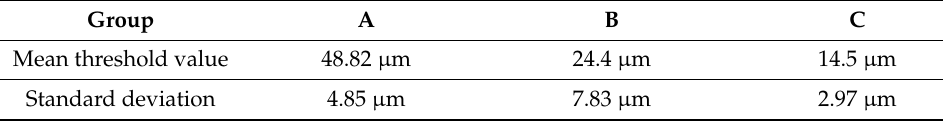
Table 2. Mean values of active tactile sensibility thresholds.